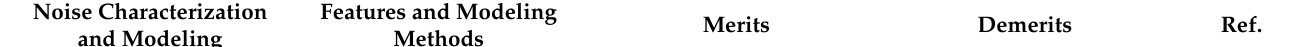
Table 1. Summary of comparison of related works on noise characterization and modeling